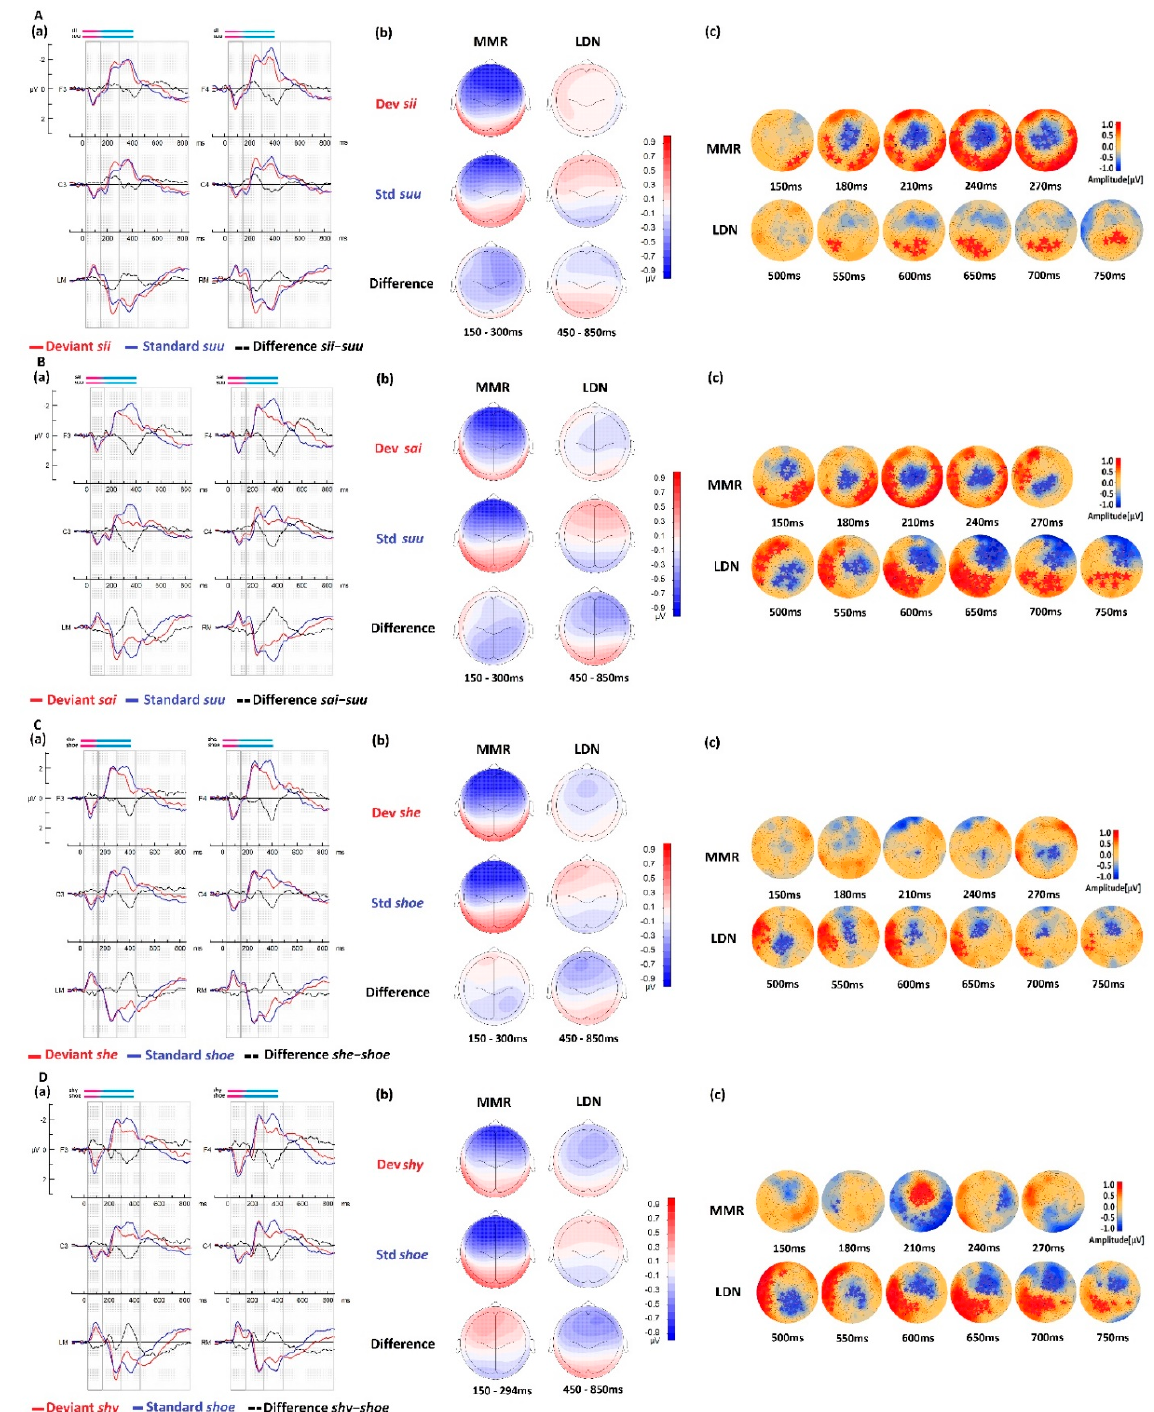
Figure 3. Average brain responses of the control group ( N = 86) to the native conditions ( A ) sii - suu and ( B ) sai - suu and to the foreign conditions ( C ) she - shoe and ( D ) shy - shoe . ( a ) ERP waveforms of the native language deviant in red, the standard in blue, and their difference wave deviant-standard in black. The windows of interest showing the MMR and the LDN components are highlighted in black boxes. ( b ) Corresponding means topographic maps over the MMR and LDN time windows. ( c ) The statistical cluster-based permutation test results showing significant differences between the responses to deviant and standard stimuli are indicated with stars. Blue and red colors indicate negative and positive amplitude values, respectively. The measuring unit is μ V.